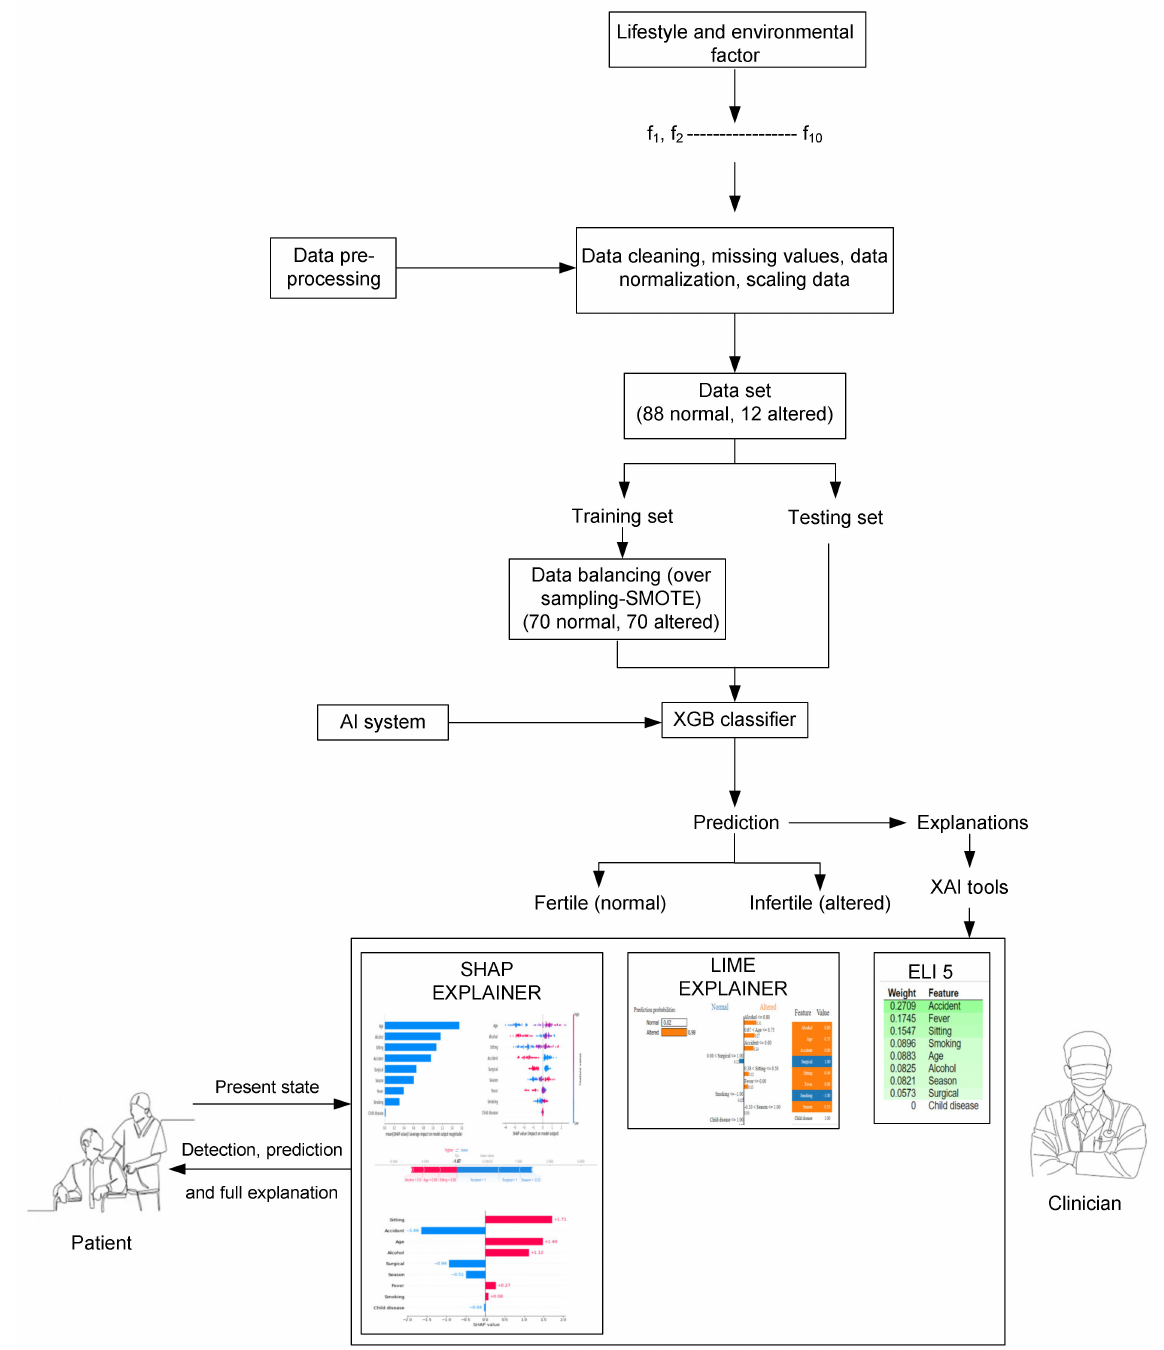
Figure 1. Methodology of the proposed system via